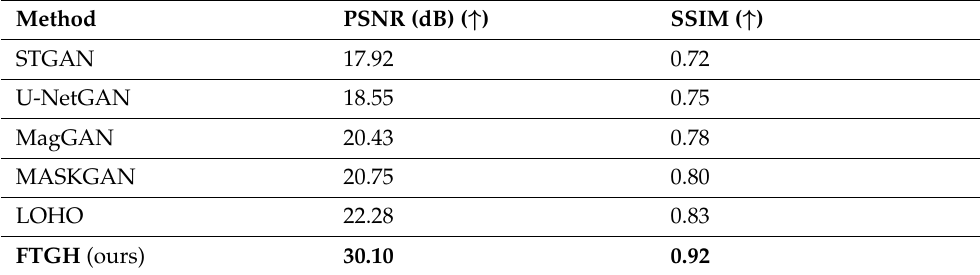
Table 4. Comparison of PSNR and SSIM of different